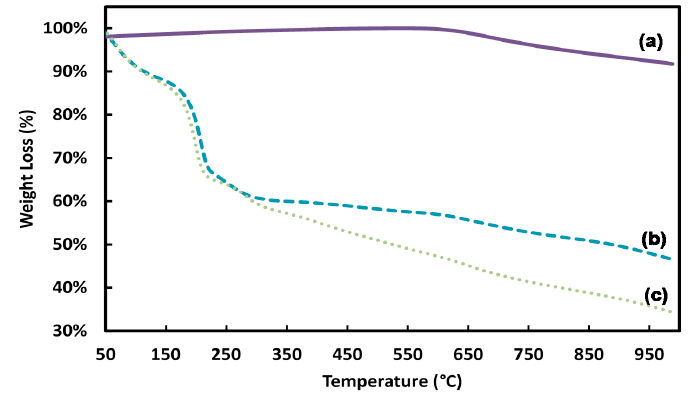
Figure 6. Thermogravimetric analysis (TGA) thermograms of ( a ) raw graphite, ( b ) GO, and ( c ) VBTAC treated GO.